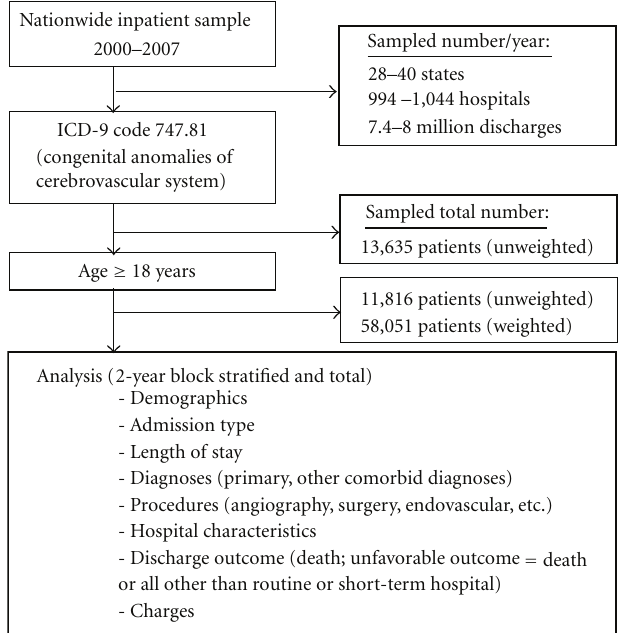
Figure 1: Selection flow